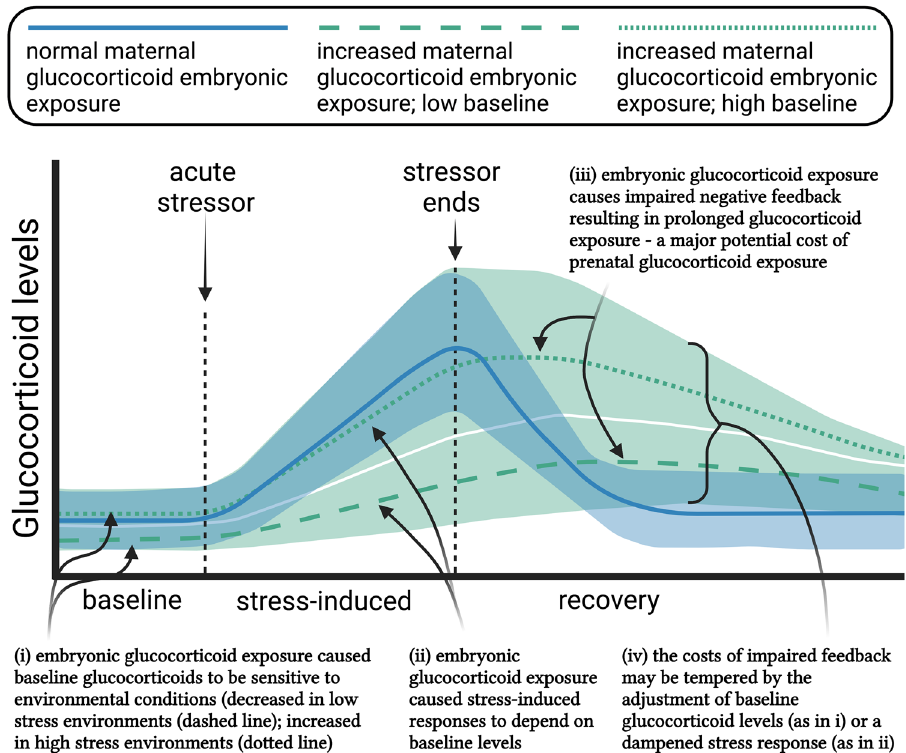
Figure 5. A concept figure detailing how elevated exposure to maternal glucocorticoids during embryonic life could alter the HPA axis and a resulting acute stress response. The mean responses for a normal acute stress response (blue solid line), embryonic glucocorticoid exposure and low postnatal environmental stress (green dashed line), and embryonic glucocorticoid exposure and high postnatal environmental stress (green dotted line) are depicted. The shaded blue (normal) and green (embryonic exposure) areas show ranges of possible acute stress responses based on our data. (i) Baseline glucocorticoids in individuals exposed to elevated embryonic glucocorticoids may be dampened in non-stressful environments (dashed green line), or normal (dotted green line) in a stressful environment (these two groups are separated by a thin white line for clarity). (ii) Upon activation of the HPA axis following a stressor, the magnitude of glucocorticoid increase may depend on baseline glucocorticoid levels. (iii) Regardless of baseline or stress-induced levels, individuals exposed to elevated embryonic glucocorticoids may have impaired negative feedback, resulting in increased cumulative glucocorticoid exposure. (iv) Impaired recovery may have both benefits and consequences to organismal health and fitness. Figure was created with